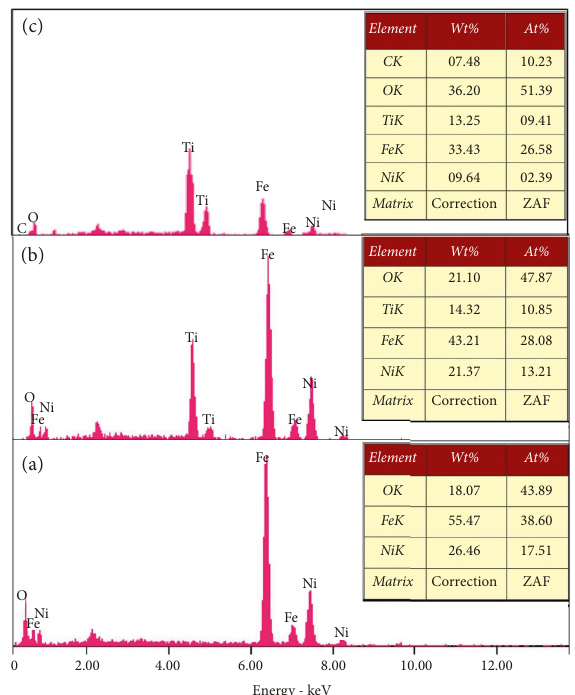
Figure 6: EDX image of (a) NiFe 2 O 4 , (b) NiFe 2 O 4 @TiO 2 , and (c) NiFe 2 O 4 @TiO 2 @rGO core@shell